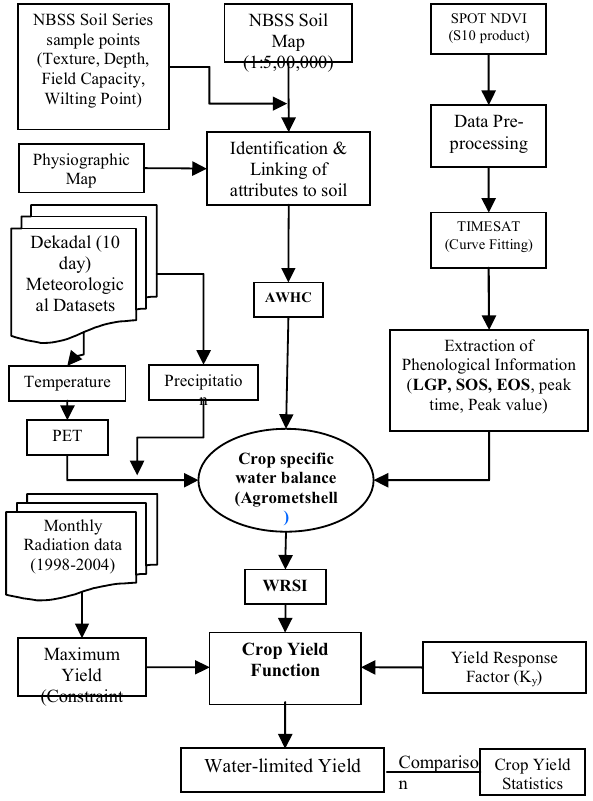
Fig. 1 Schematic diagram for geospatial estimation of WRSI